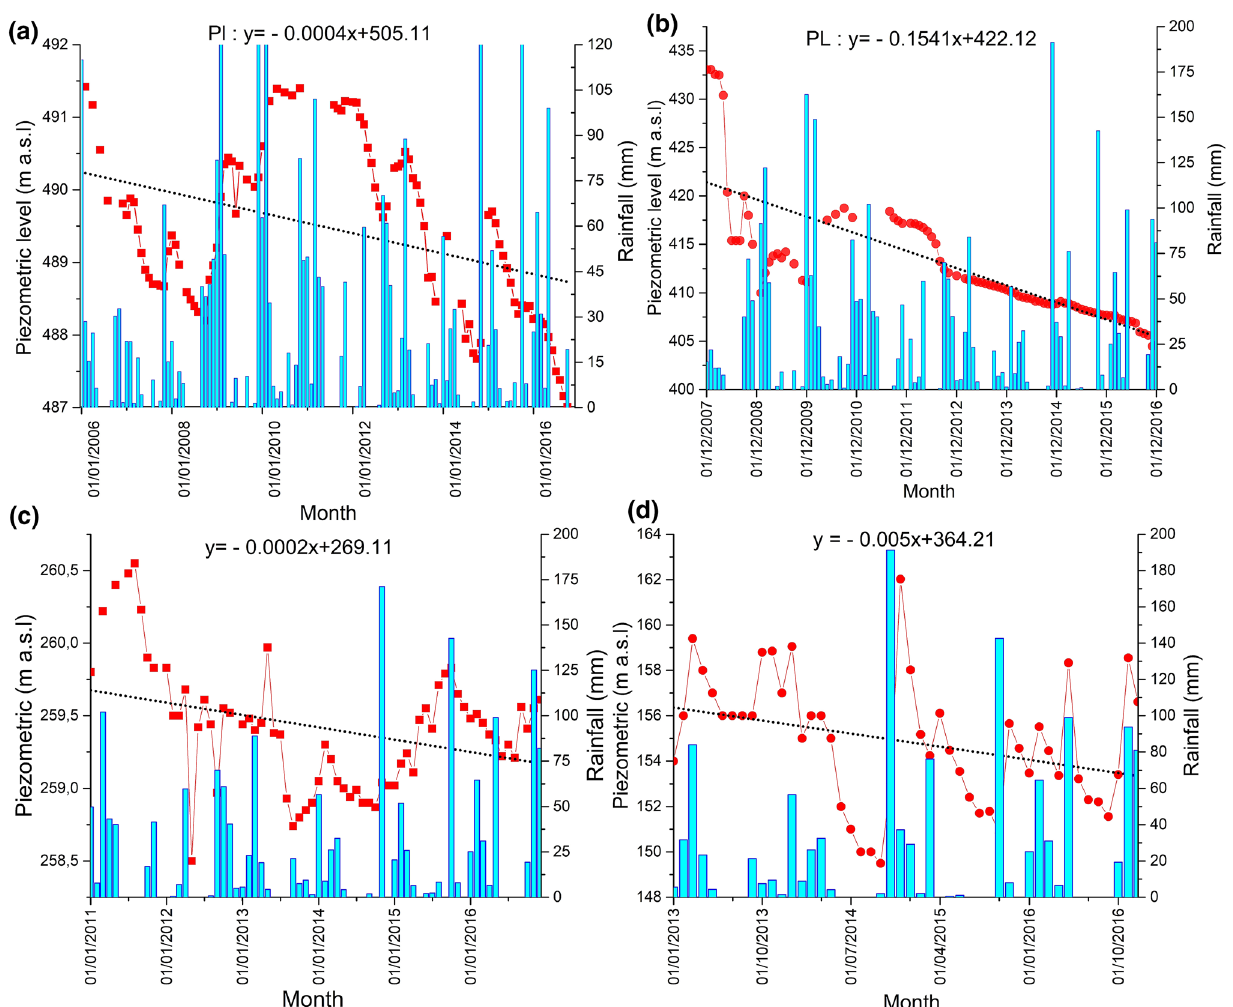
Fig. 3 Piezometric levels for the period 2006–2016 in the study